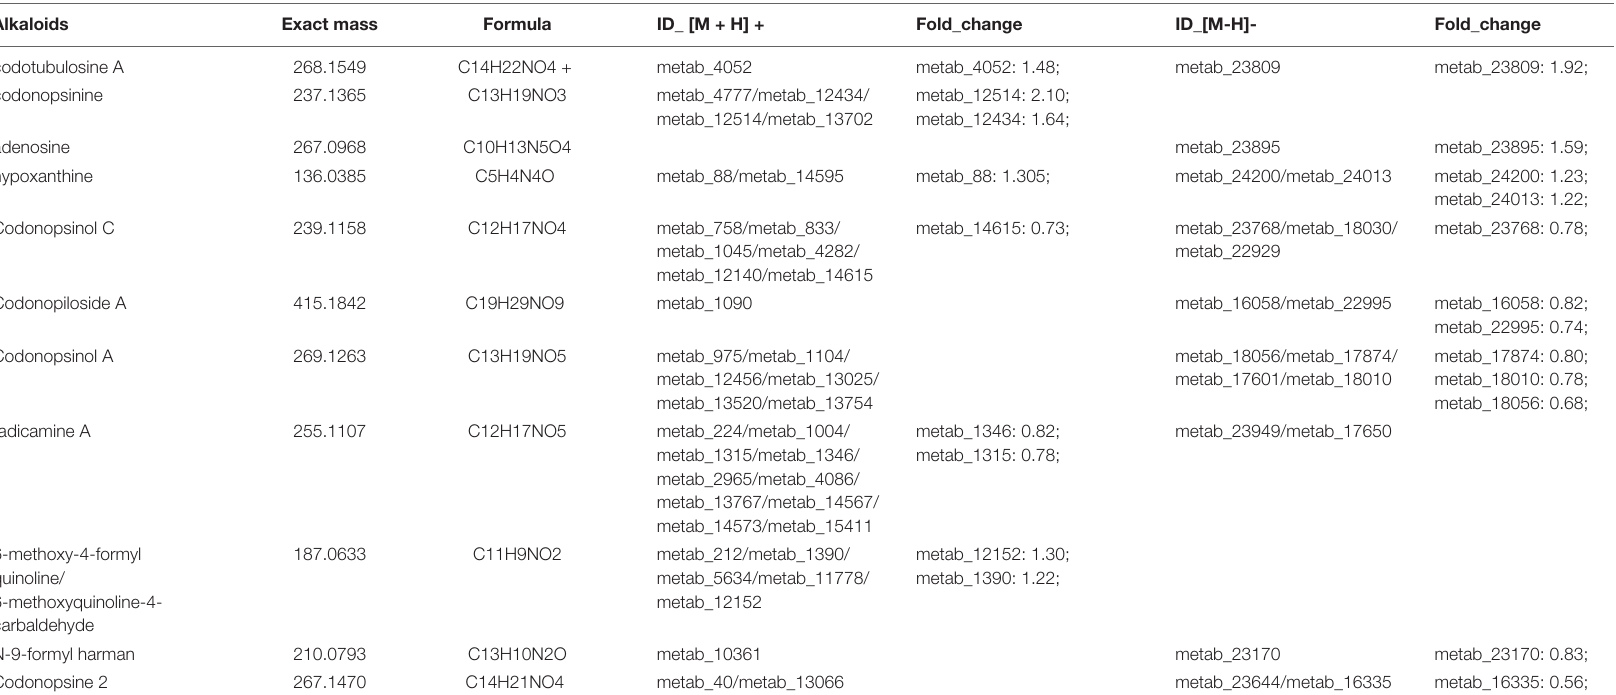
TABLE 4 | Differentially expressed metabolites (DEMs) annotated as